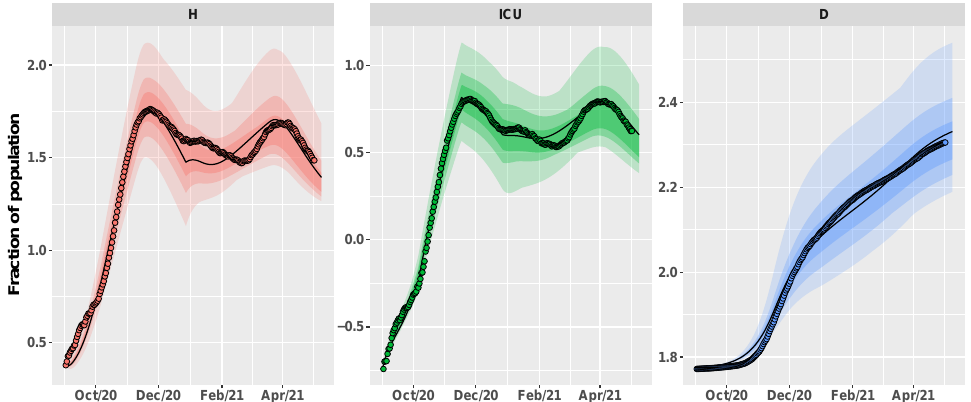
Figure 10. Italy. Time behavior of H, ICU, and D variables using as parameter vector the final mode vector computed by CRC (black line) (see Table 1); dots are the public data available in [32]. Both data and simulations are in log-scale, normalized over the population of Italy ( ∼ 60 million) and multiplied by 100,000. The colored area represents the variation of the temporal behavior when the parameter vector varies between the 60th, 70th and 90th percentile of its conditional pdf (see Table